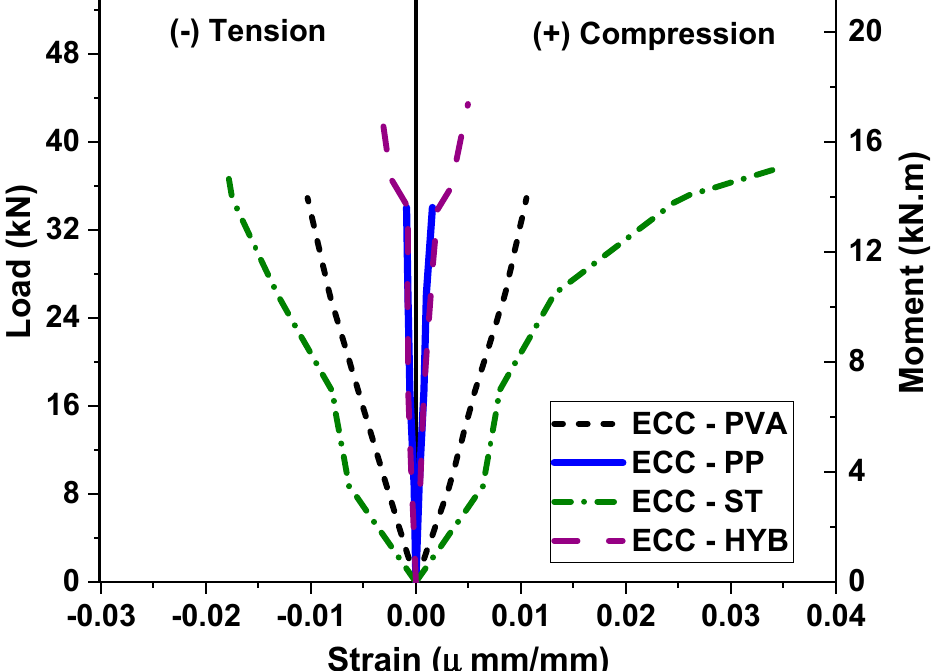
Figure 7. Load–strain behavior of ECC specimens with different fibers.